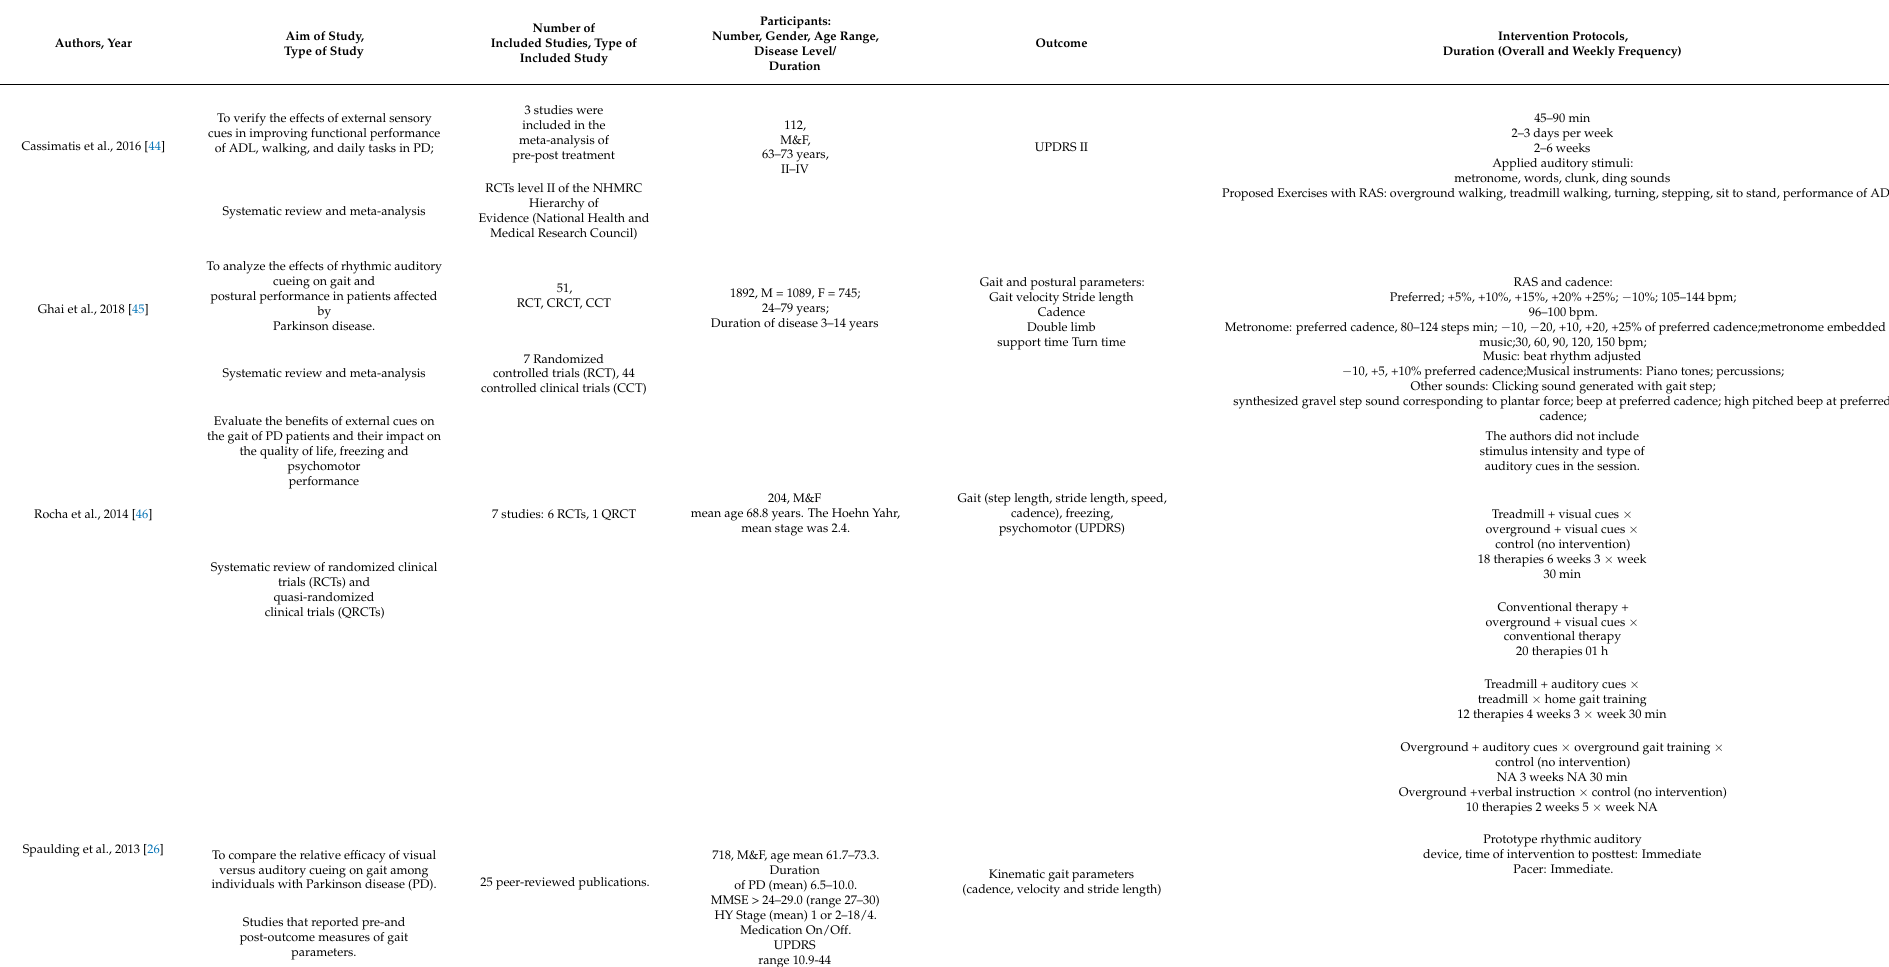
Table 2. Characteristics of included studies and overall